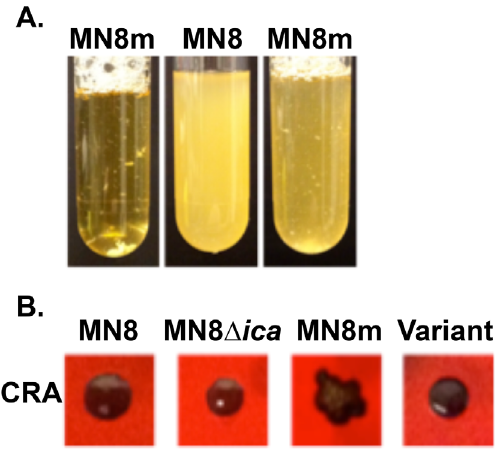
Figure 1. Phenotype characterization of non-mucoid variants isolated from mucoid strain MN8m. A. Liquid cultures in TSBG of highly aggregative mucoid MN8m (tube 1), non-mucoid MN8 (tube 2), and MN8m with mixed appearance (tube 3). B. PNAG production of MN8, MN8 D ica , MN8m, and a non-mucoid variant as indicated by colony morphology on Congo red agar